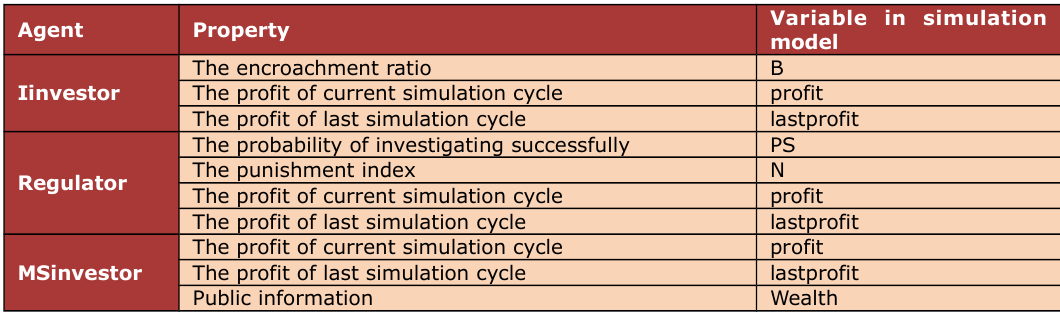
Table 1. The main properties of the simulation